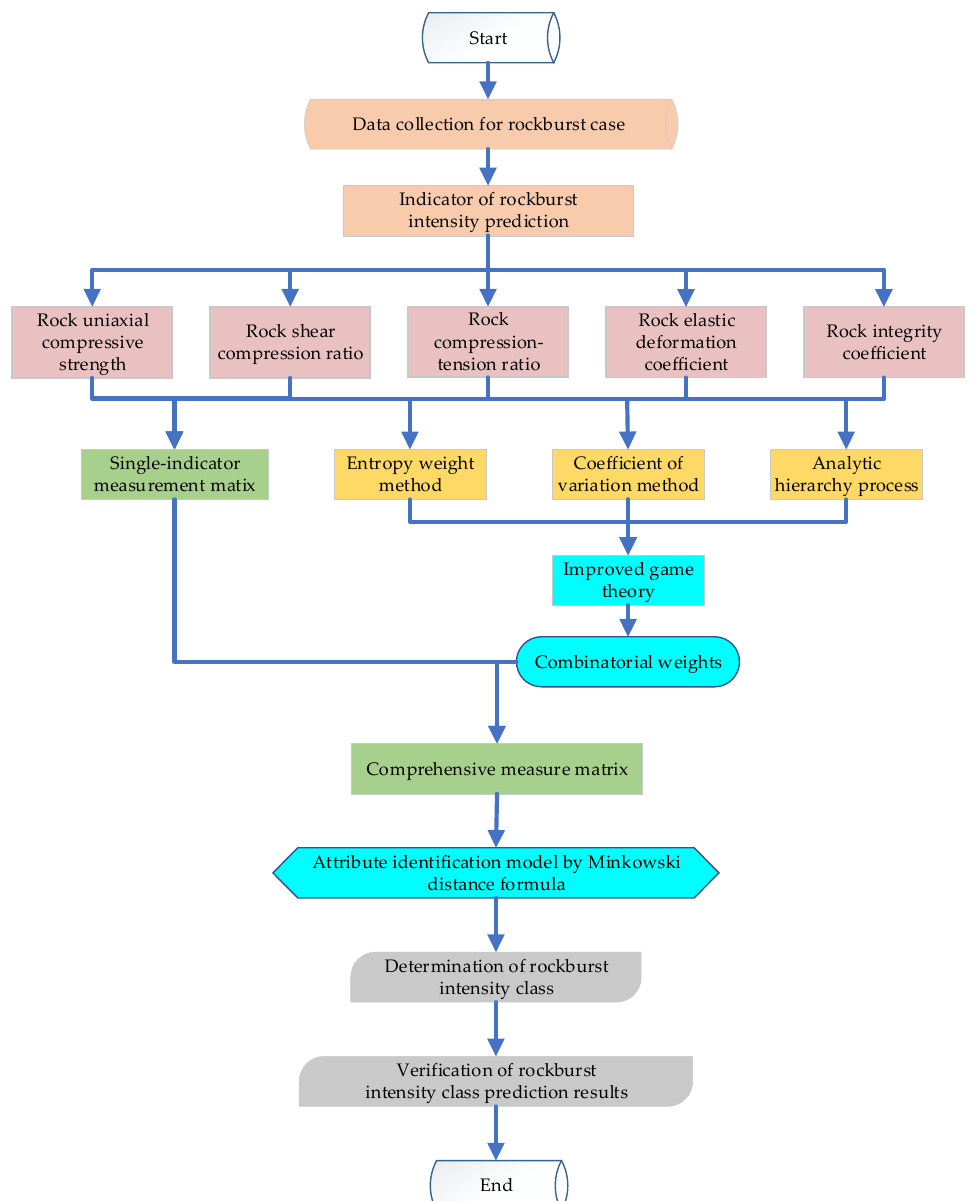
Figure 1. Model framework for predicting rockburst intensity.